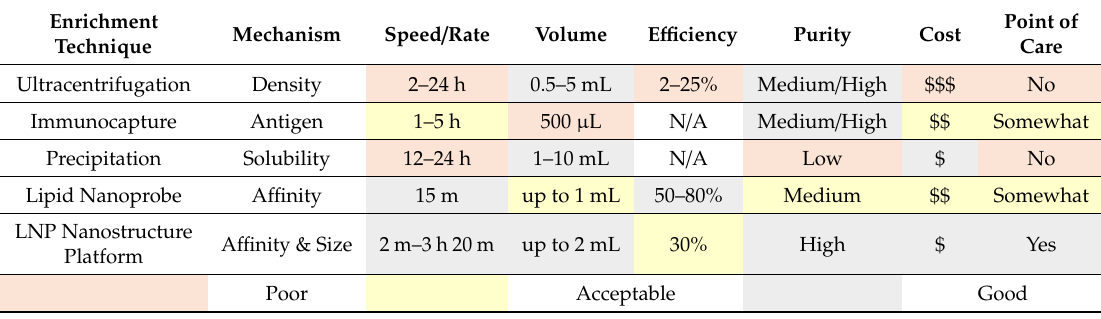
Table 1. Comparison of existing techniques for isolation and enrichment of extracellular vesicles